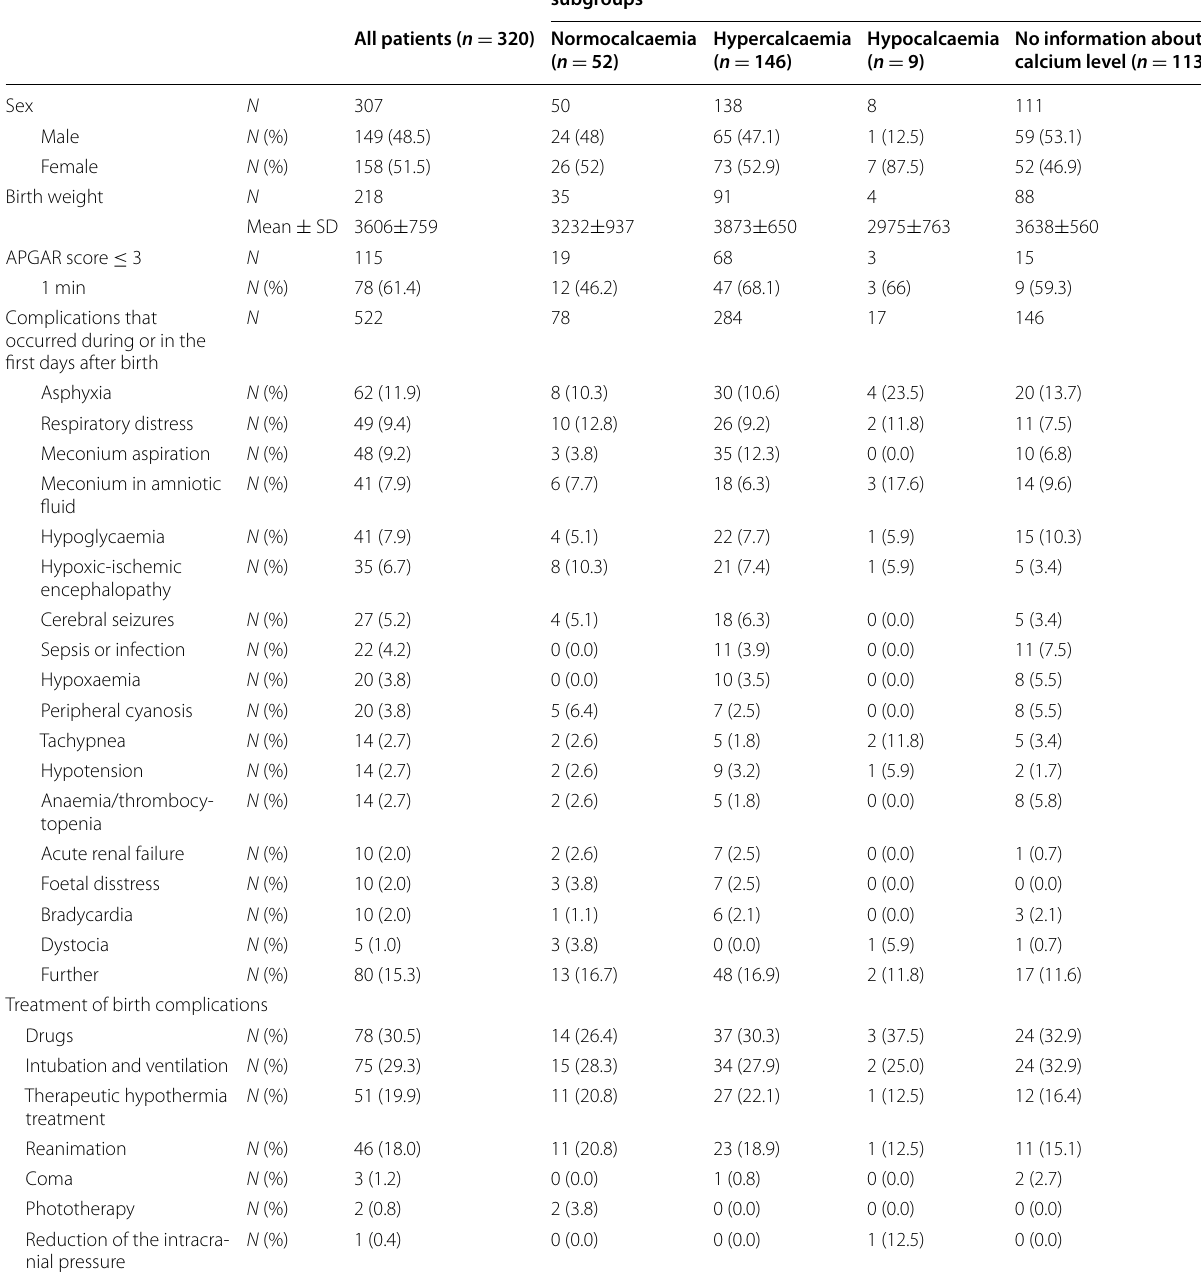
Table 2 Birth characteristics in newborns with SCFN